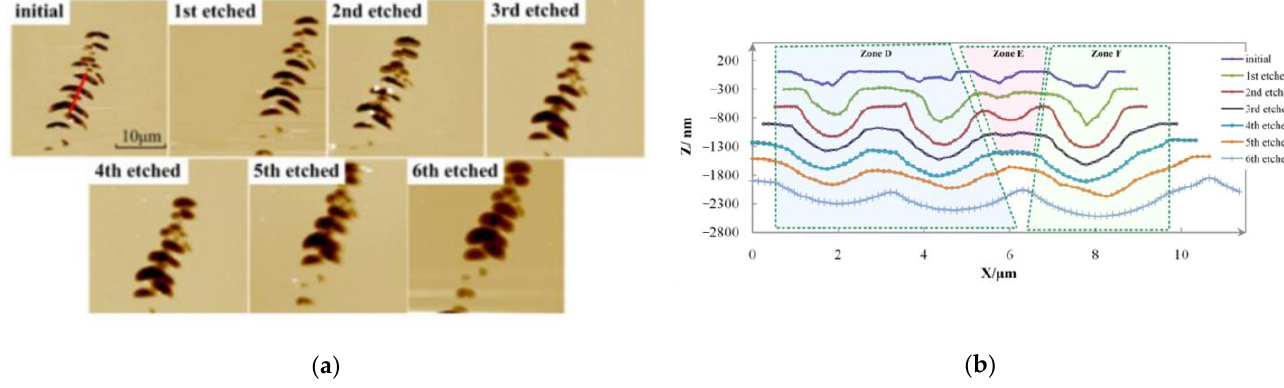
Figure 4. Defect’s morphology evolution during HF etching transformation process. ( a ) AFM pictures; ( b ) section profile curves. Table 2. Profile data during HF etching of the left pit in Zone,